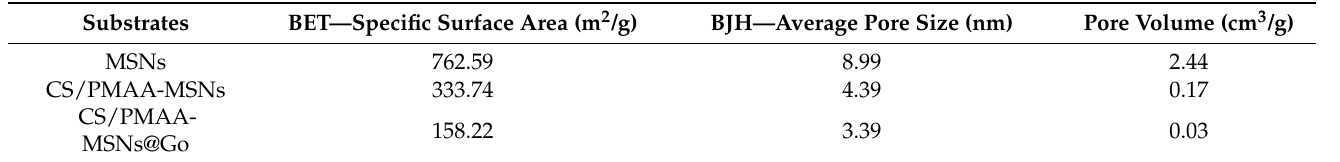
Figure 8. ( A ) N 2 − adsorption − desorption isotherms and ( B ) pore-size distributions of MSNs, CS/PMAA-MSNs, and CS/PMAA-MSNs@Go. Table 1. BET and BJH parameters of MSNs, CS/PMAA-MSNs, and CS/PMAA-MSNs @GO. Substrates BET—Specific Surface Area (m 2